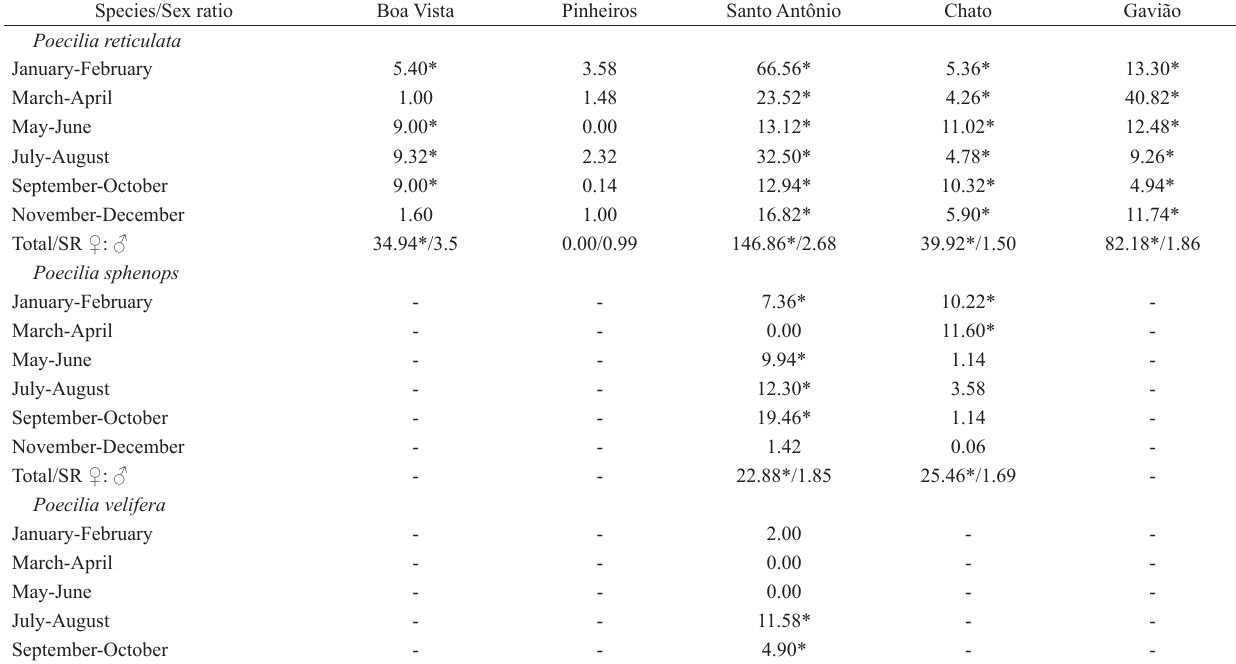
= 3.841, d.f. = 1). 0.05